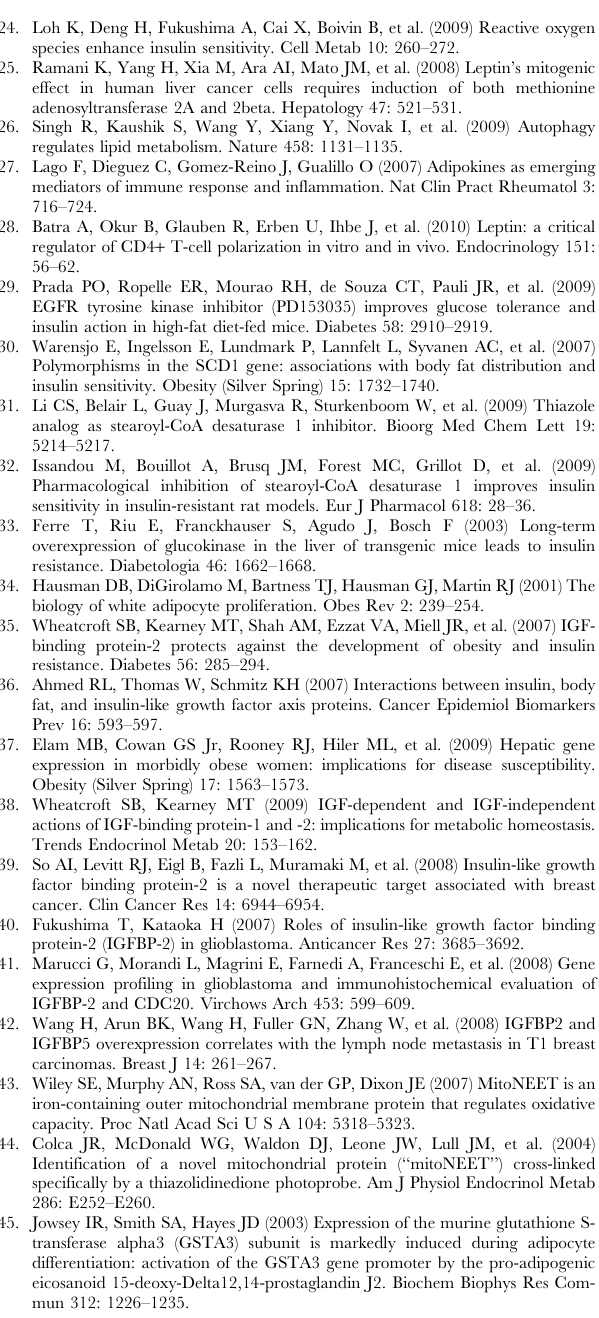
Table S1 Differentially expressed genes could be sub-divided into two major groups: 116 genes of Cluster-1 and Cluster-2 (group-A), and 98 genes of Cluster-3 and Cluster-4 (group-B). These two groups of genes were separately analyzed and were mapped to cellular compartments and biological